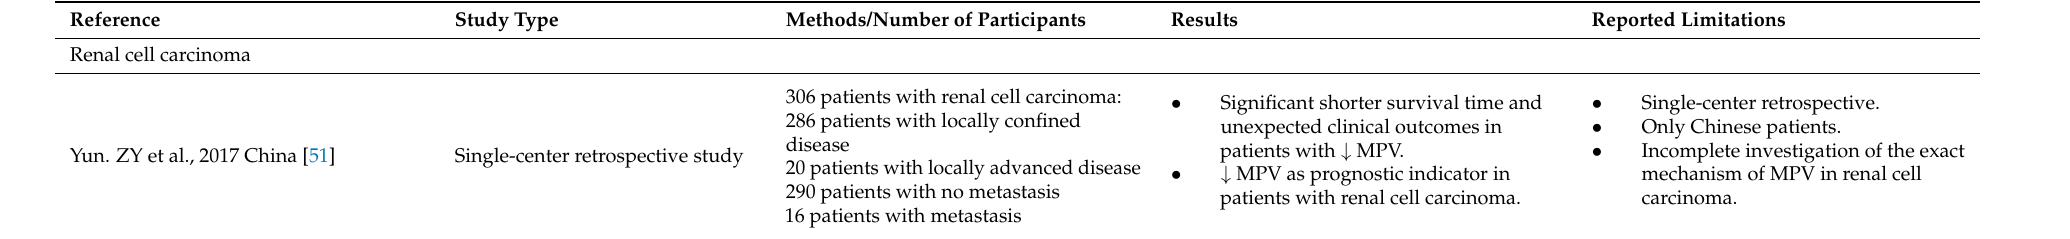
Table 3. Studies relating MPV to renal cell